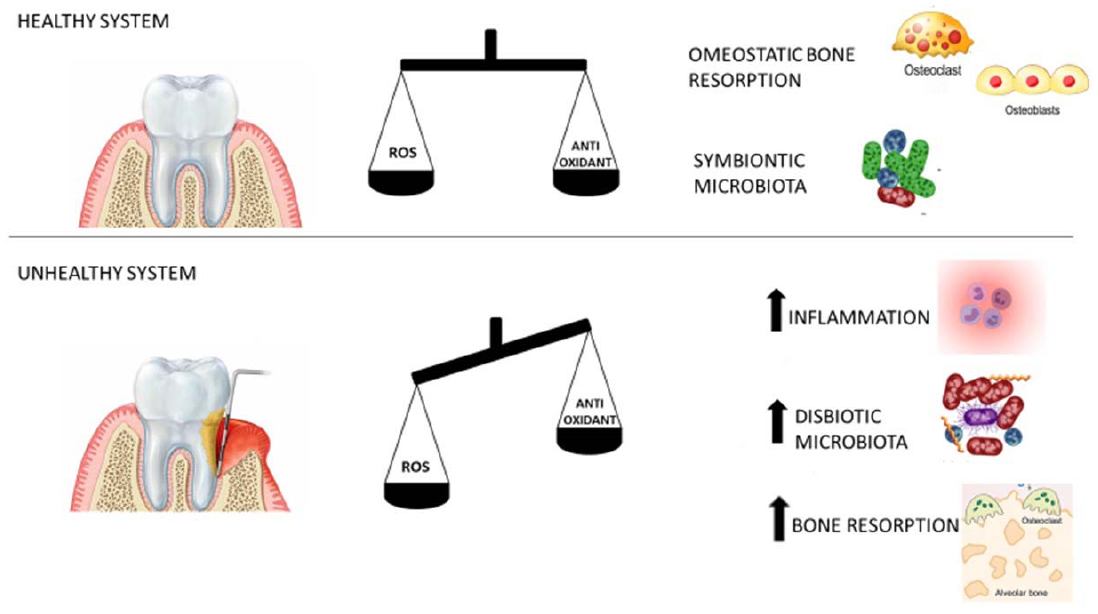
Figure 2. In a healthy system there is a balance between reactive oxygen species (ROS) and antioxi- dant concentration. This equilibrium allows for maintaining homeostasis in the periodontal tissue structures. If ROS level, for some reason, becomes higher than the antioxidant level, the balance is broken. In that situation, the high level of ROS causes inflammation in the periodontal tissue. At the same time, the microbiota communities change in favor of virulent bacterial communities, this causes the instauration of a dysbiotic microbiota. If this condition is not resolved, it becomes chronic, and the permanence of these mechanisms causes the destruction of the periodontal tissues.